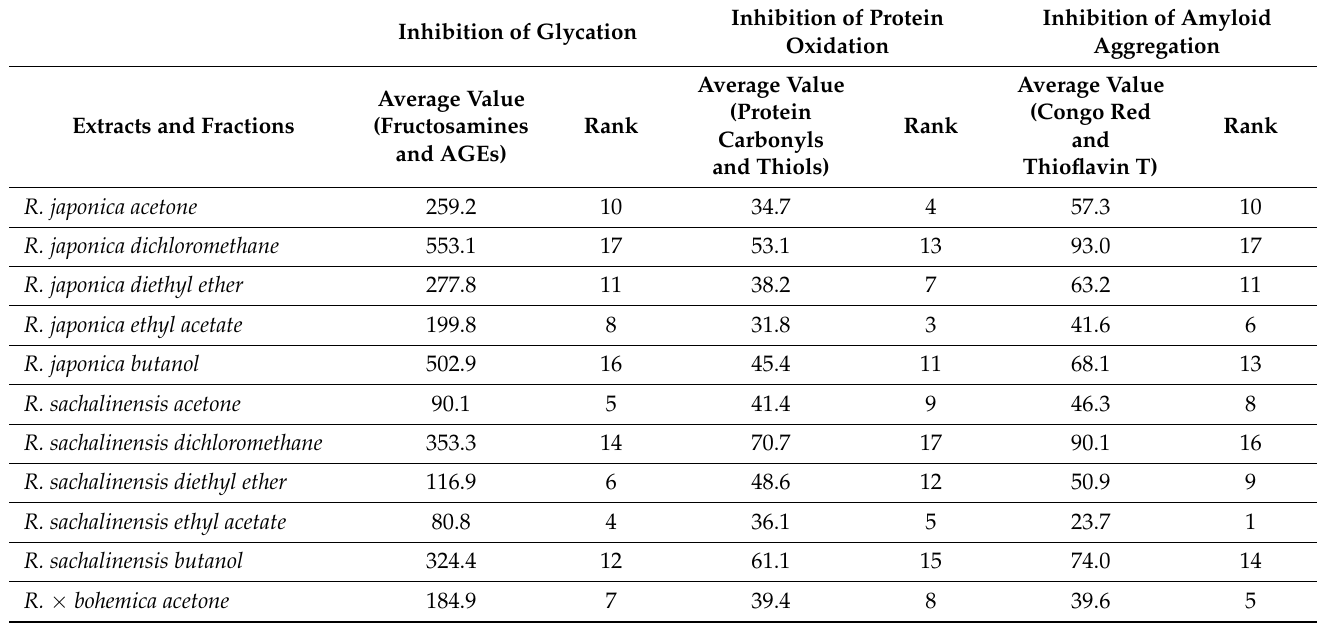
Table 2. The summary of antiglycoxidation potential for each of the analyzed extracts and fractions at three stages of glycooxydation and their relative ranking (for